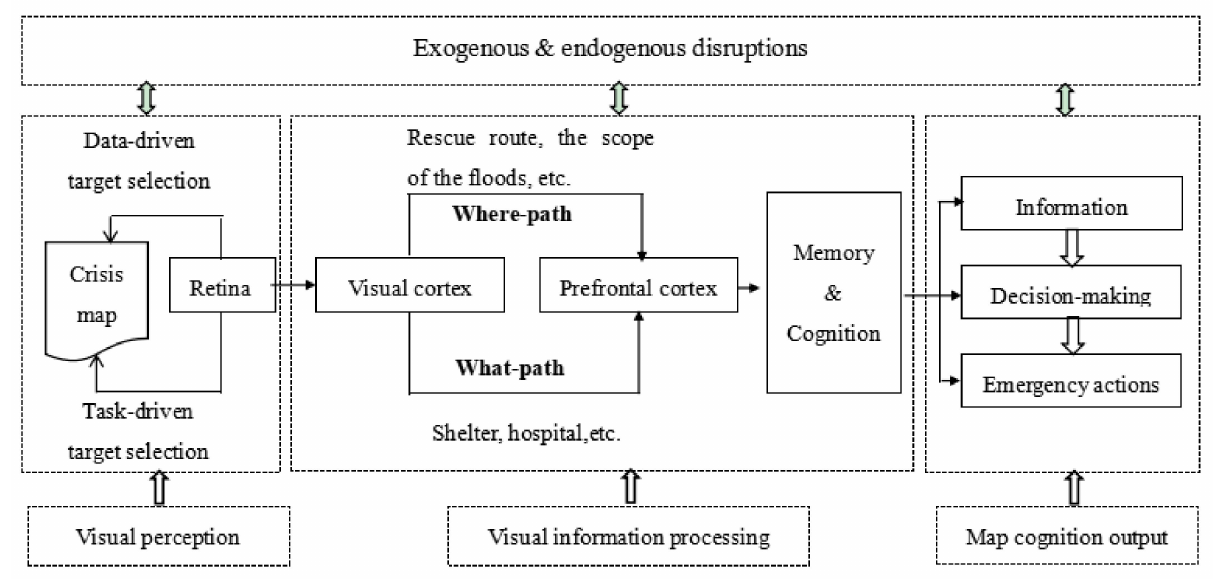
Figure 2. Crisis map visual cognition